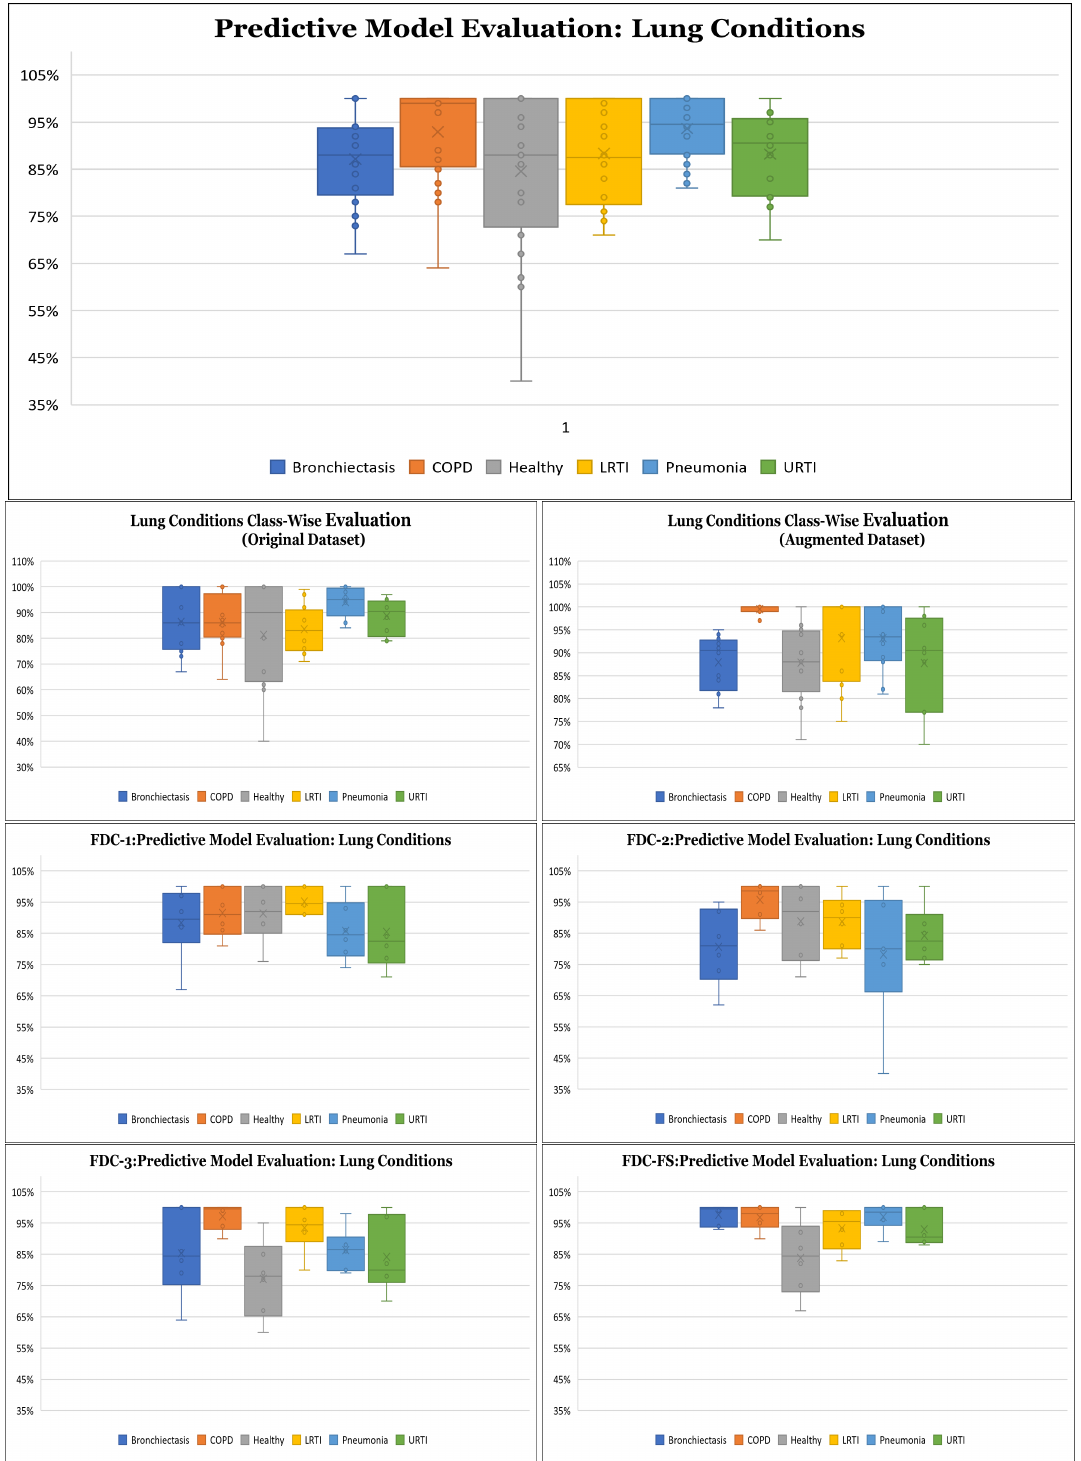
Figure 10. Class Wise Accuracy for Lung Condition